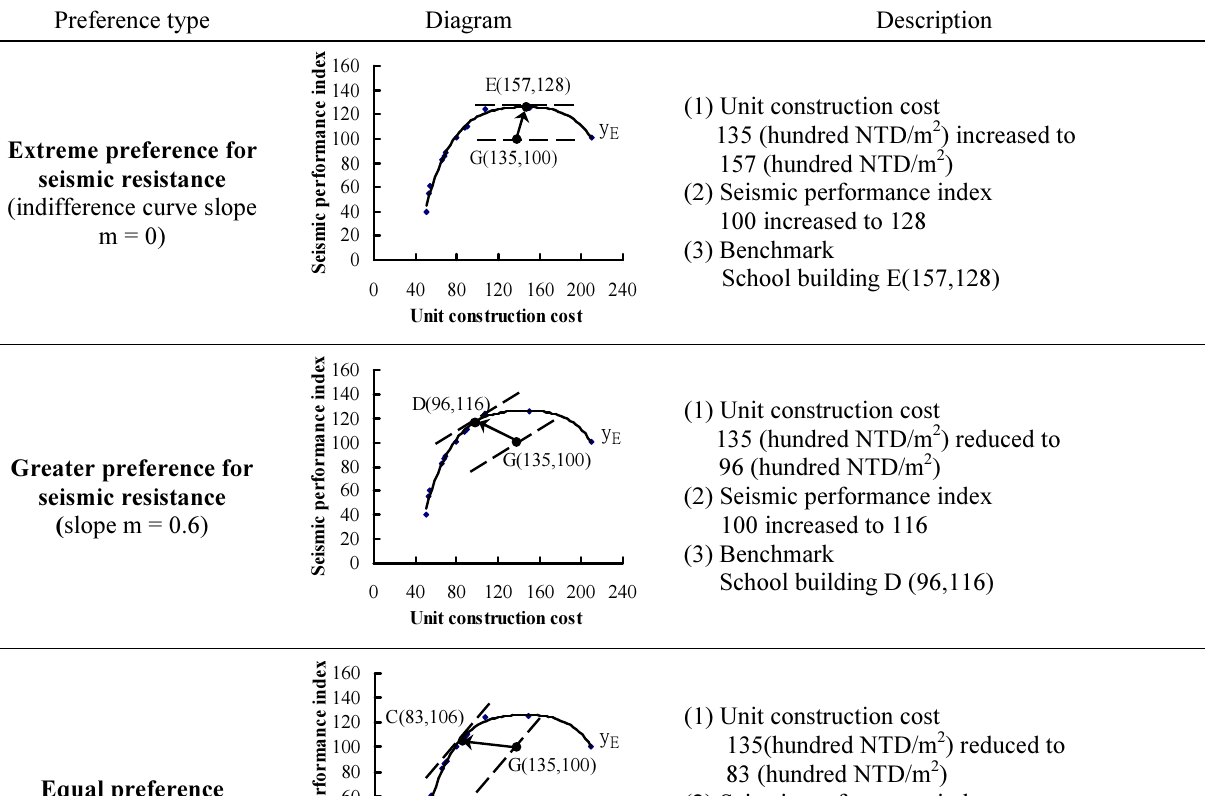
Table 4. Benchmarks of the empirical research for five planning preference